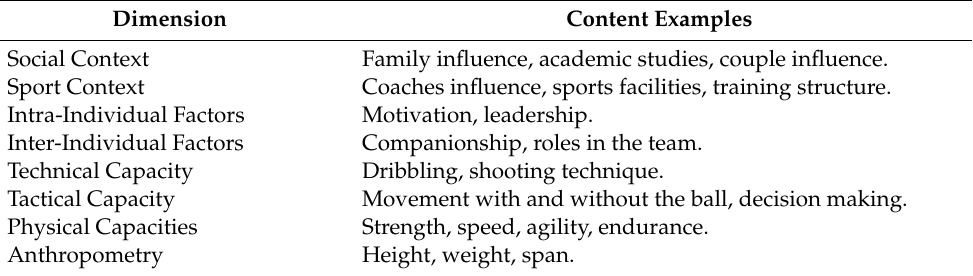
Table 1. Interview